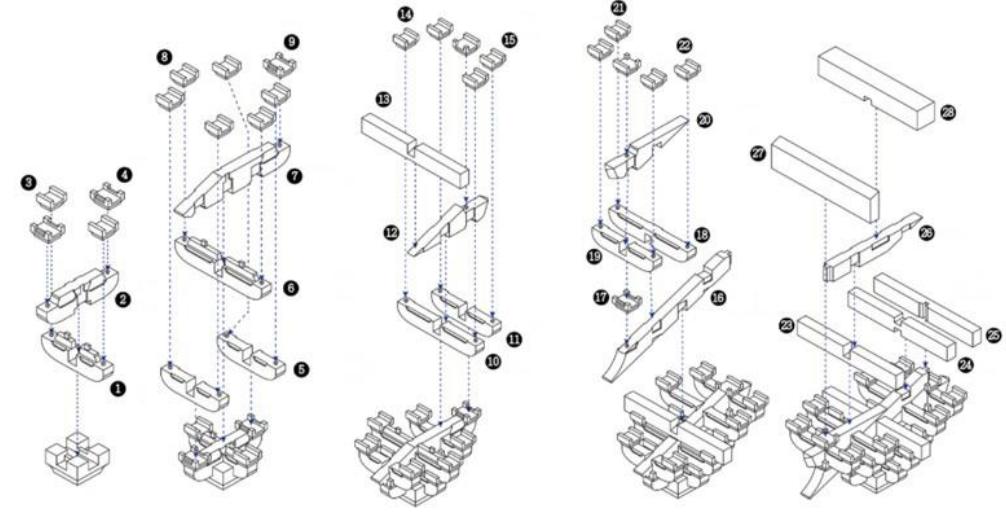
Figure 2. Paper-based instructions used in preliminary experiments.